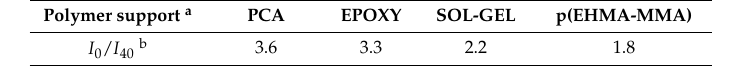
Table 3. Temperature sensitivity of the luminescence of [Ru(phen) 2 (4-Clp)] 2+ immobilized into different